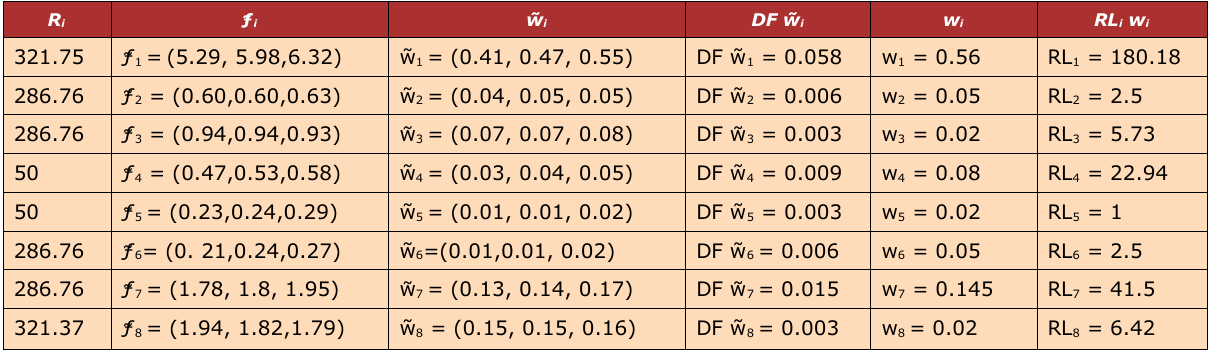
Table 14. Final Results of FAHP